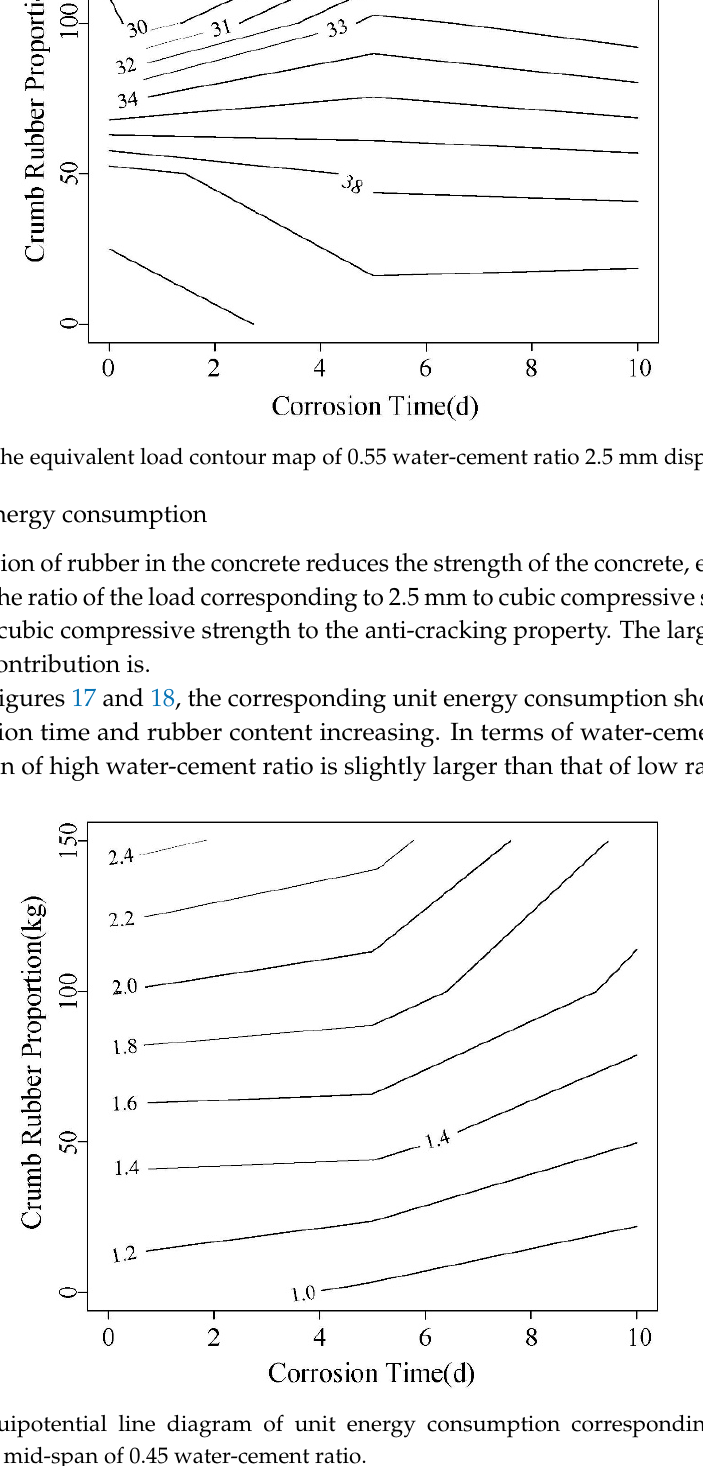
Figure 15. The corresponding load contour maps for 0.45 water-cement ratio 2.5 mm displacement.